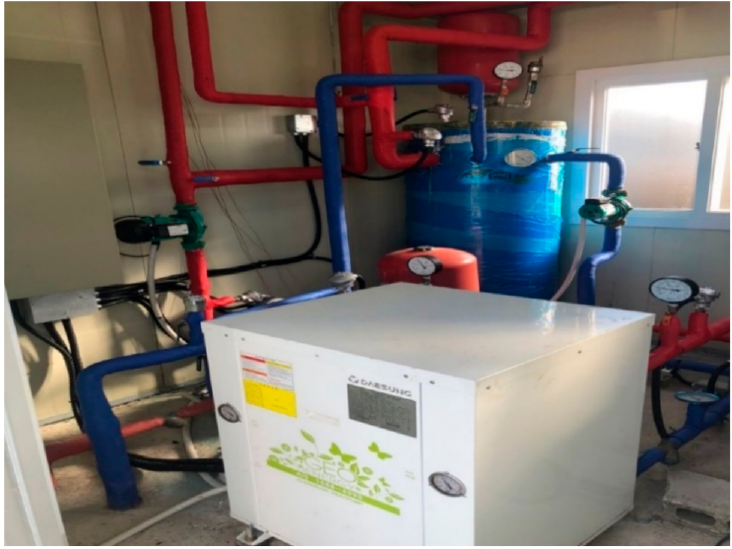
Figure 3. GHP system with a water tank and pipes installed at the pig